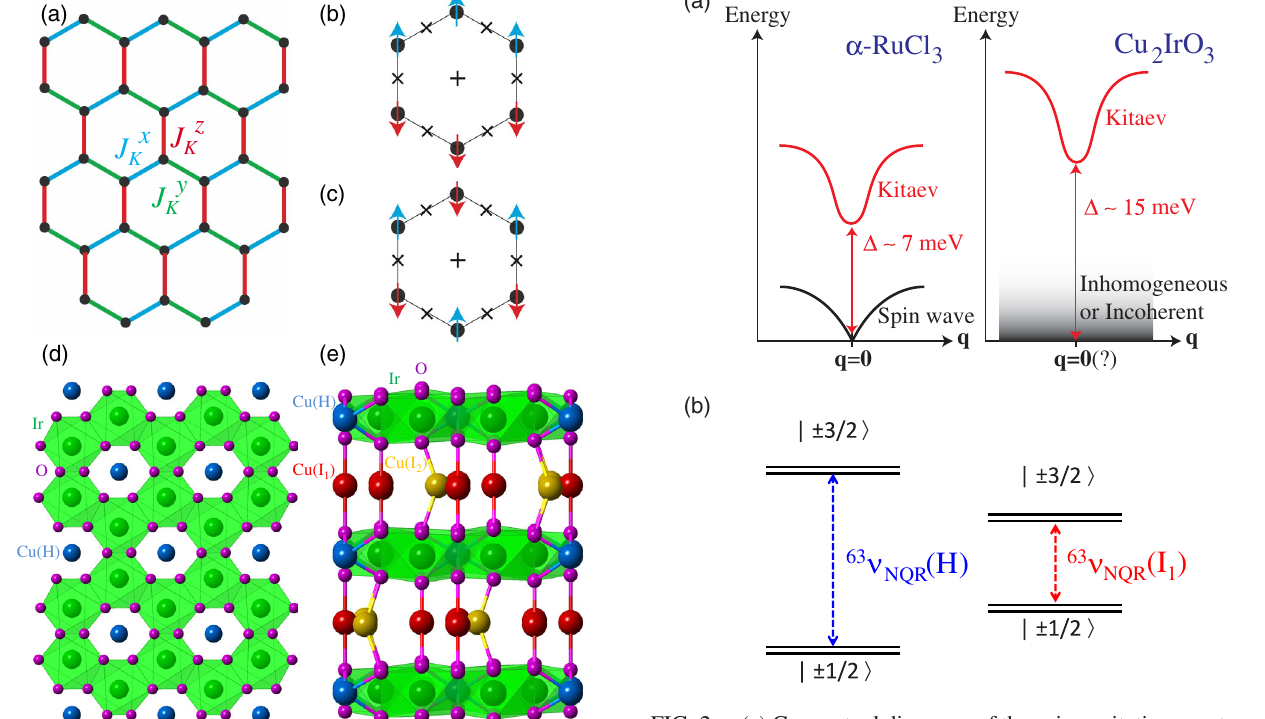
FIG. 2. (a) Conceptual diagrams of the spin excitation spectrum in Kitaev candidate material α -RuCl 3 with additional spin-wave- like modes below the gap Δ ∼ 7 meV [19 – 21] (left), and Cu 2 IrO 3 with only spatially inhomogeneous, incoherent spin excitations at low energies (right). (b) Schematic diagram of the quadrupolar splitting between the nuclear spin j(cid:3) 1 = 2 i and j(cid:3) 3 = 2 i states for 63 Cu ð H Þ and 63 Cu ð I 1 Þ